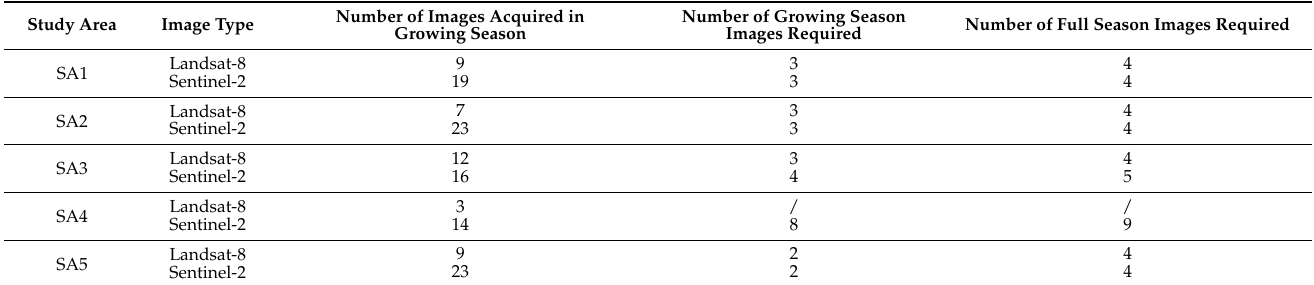
Table 6. Number of images acquired in the growing-season and the length of the shortest image time series (acquired in growing seasons/all seasons) to reach the optimal classification accuracy based on spatial features